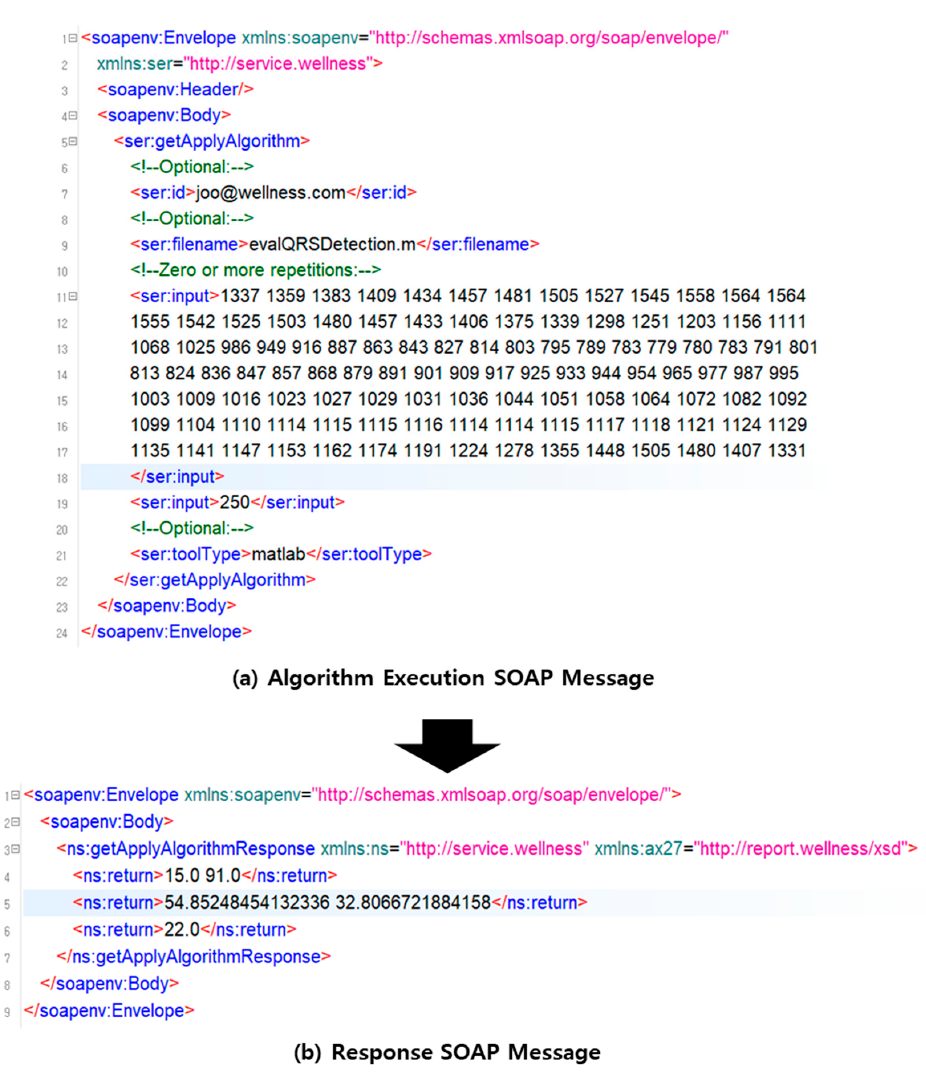
Figure 12. SOAP message of vital sign analysis algorithm execution; ( a ) SOAP message to request the algorithm execution; ( b ) response SOAP message with the algorithm executed.